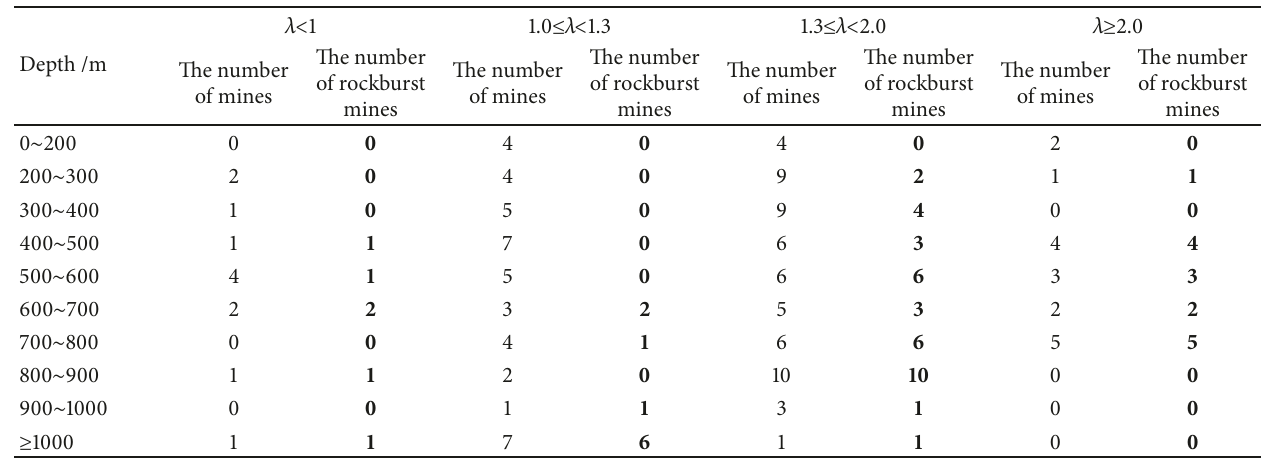
Table 2: Statistics data of rockbursts coal mines with different 𝜆